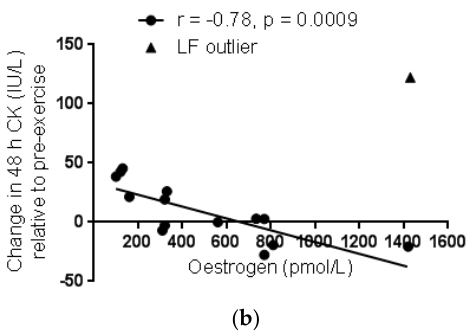
Figure 3. Linear regression of the change in serum creatine kinase (CK) activity over pre-exercise values at 24-h ( a ) and 48-h ( b ) post exercise with serum oestrogen concentration in women. Correlation analysis is excluding the one individual outlier from the LF group.